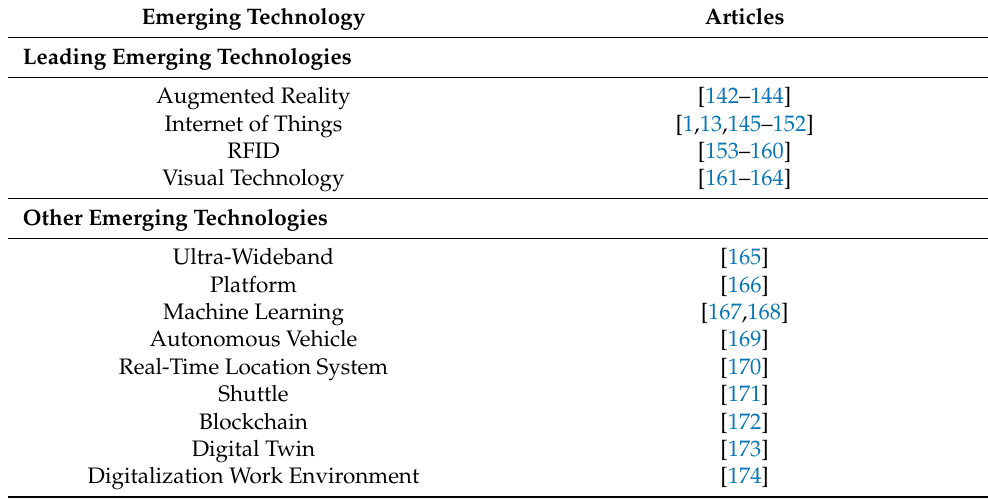
Table 2. Articles belonging to category “Implementation”, source: own work. Emerging